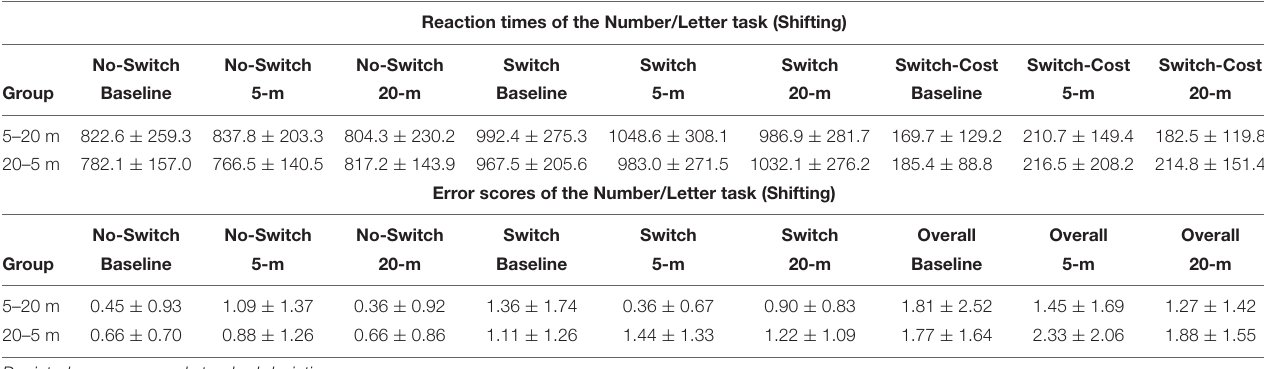
TABLE 2 | Reaction times and error scores of the Number/Letter task separated by test condition and experimental group. Reaction times of the Number/Letter task (Shifting)